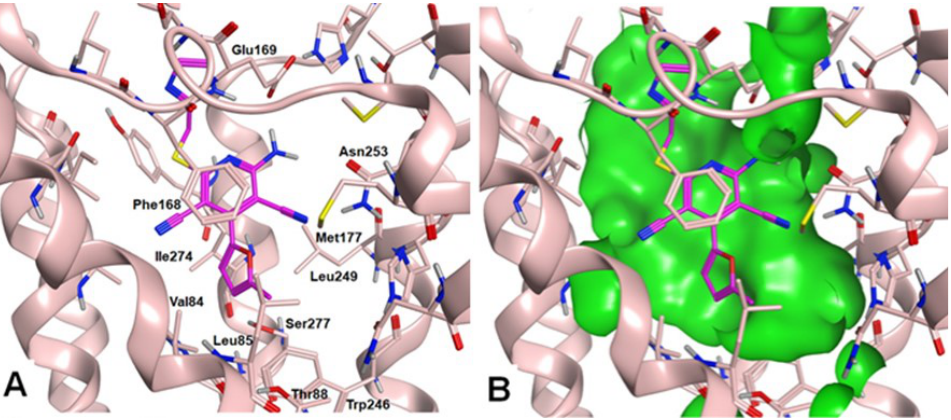
Figure 5. ( A,B ) Binding mode of compound 3 at the hA 2A AR cavity. ( A ) Compound 3 –receptor interaction is shown, with indication of key receptor residues.